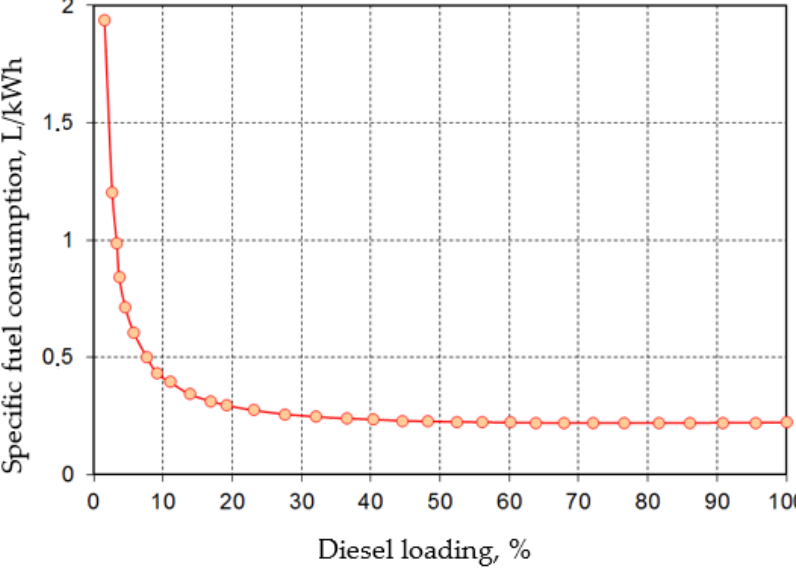
Figure 4. Specific fuel consumption change for a 400 kW DG depending on the load. Adapted from Ref. [83].